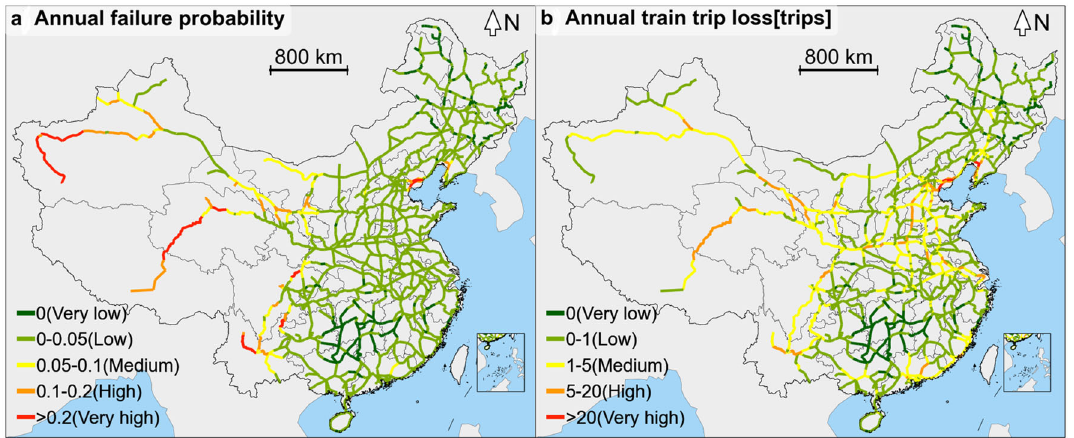
Fig. 8 Annual failure probability ( a ) and risk ( b ) of the Chinese railway system